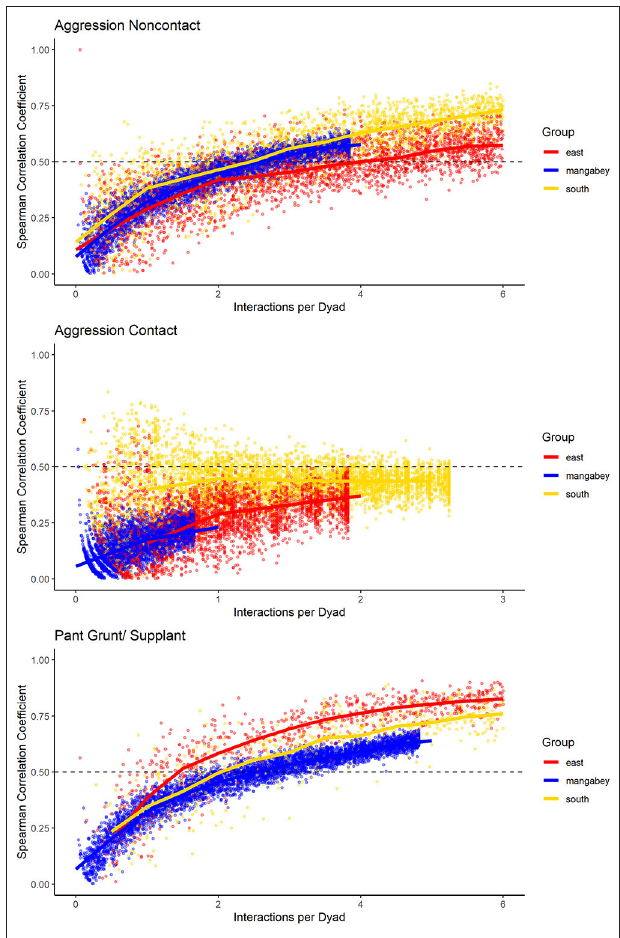
FIGURE 8 | Spearman correlation between two halves of randomly selected subsets of the datasets for mangabeys (blue), East chimpanzee community (red) and South chimpanzee community (golden) for noncontact aggression, contact aggression, and pant grunts/supplants. The standardized consistency is marked by the number of interactions per dyad where the median of correlation coefficients exceeds r s = 0.5. If that value is reached with fewer interactions per dyad, the distribution of interaction rates is more consistent. Distributions of correlation coefficients with a large spread indicate changes in interaction preference over